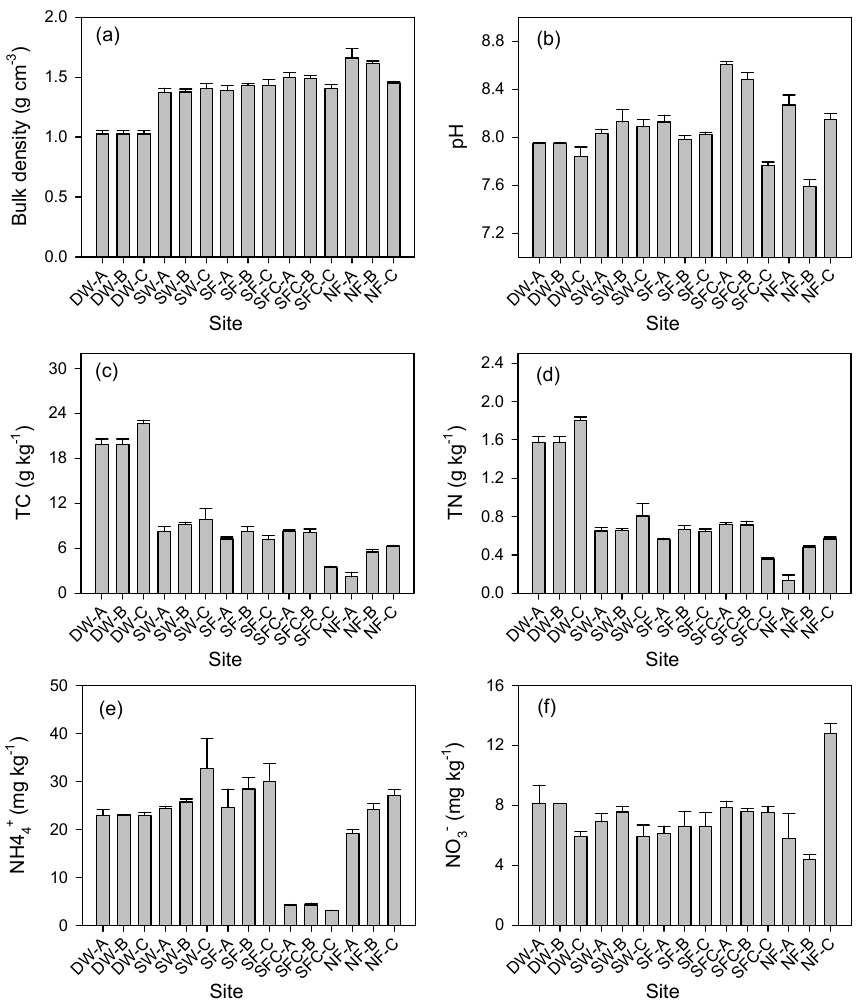
Figure 3. Physicochemical properties (mean ± SE) of soil–sediment of each site. Some SE bars are not visible because they are too small. DW: deep water site; SW: shallow water site; SF: seasonally flooded site; SFC: “control site” for the seasonally flooded site; NF: